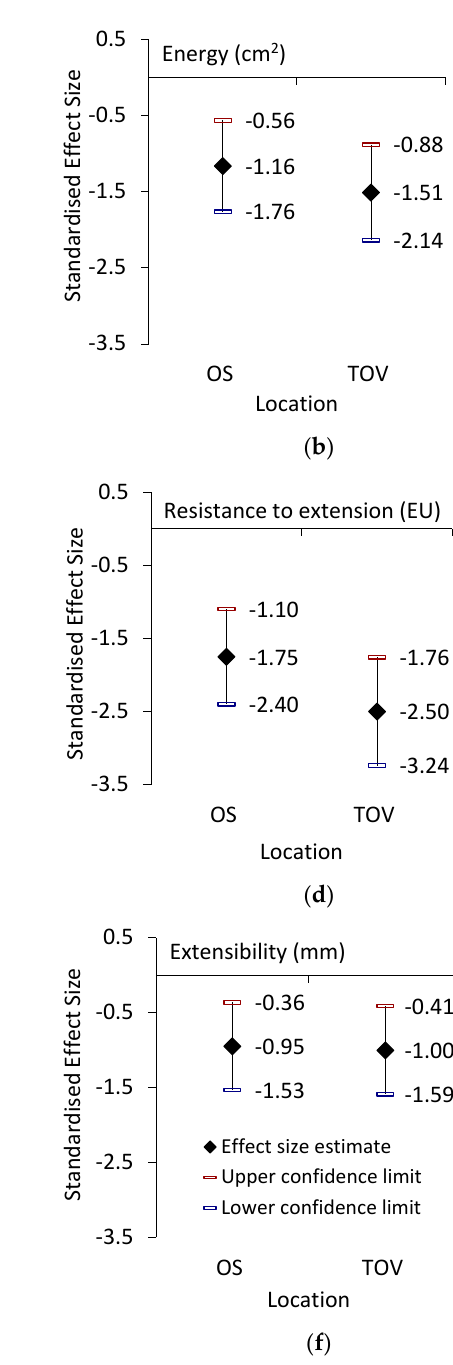
Figure 5. Boxplot plots of extensographic dough properties for investigated control (uninfected, CON) (n = 25) and infected (INF) (n = 25) winter wheat cultivars grown at different locations (OS, TOV): ( a ) energy (E, cm 2 ), ( c ) resistance to extension (RtE, EU) and ( e ) extensibility (Ext, mm), and estimates of standardized effect size with a 95% confidence interval of Fusarium infection impact on the same properties: E ( b ), RtE ( d ), and Ext ( f ). The box represents the middle 50% of observed values; the bottom of the box is the 25th percentile and the top of the box is the 75th percentile of the data; the line in the middle of the box is the median (50th percentile) and the plus sign (+) is the mean value; the whiskers extend to the lowest and greatest non-outliers’ value, and circles are used to represent outliers. Boxplots marked with the same letter are not significantly different according to multiple pairwise comparisons using the Conover-Iman procedure/two-tailed test at a p < 0.05 significance level.